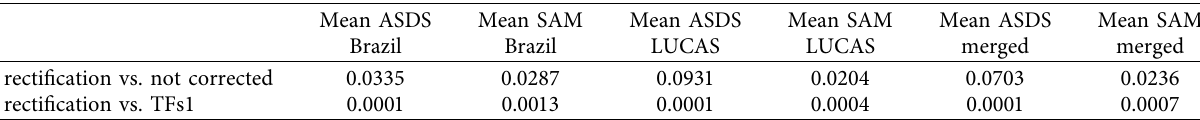
ISS rectifcation vs. not